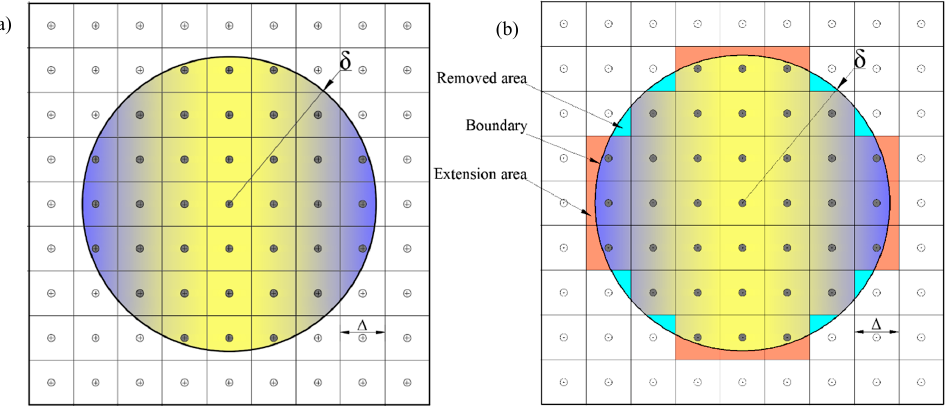
Figure 2. PD computational domain: ( a ) ideal region and ( b ) actual PD region.